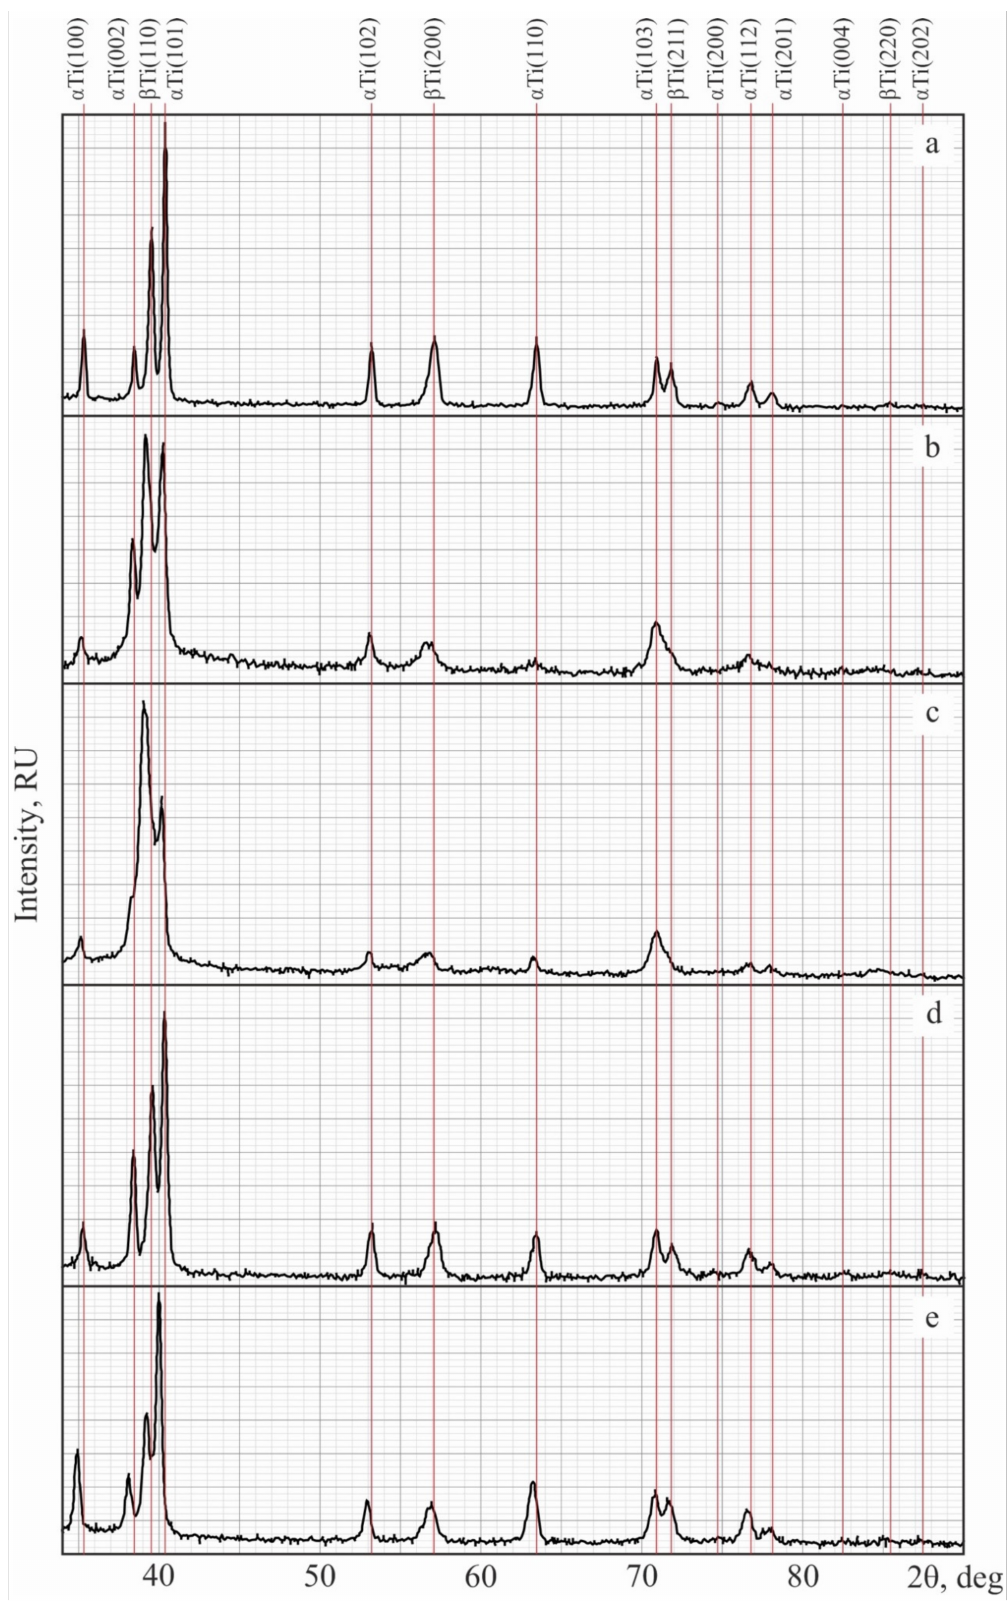
Figure 5. Diffractograms of the α + β titanium alloy after various treatments (Table 2): ( a )—series 1; ( b )—series 2; ( c )—series 3; ( d )—series 4; ( e )—series